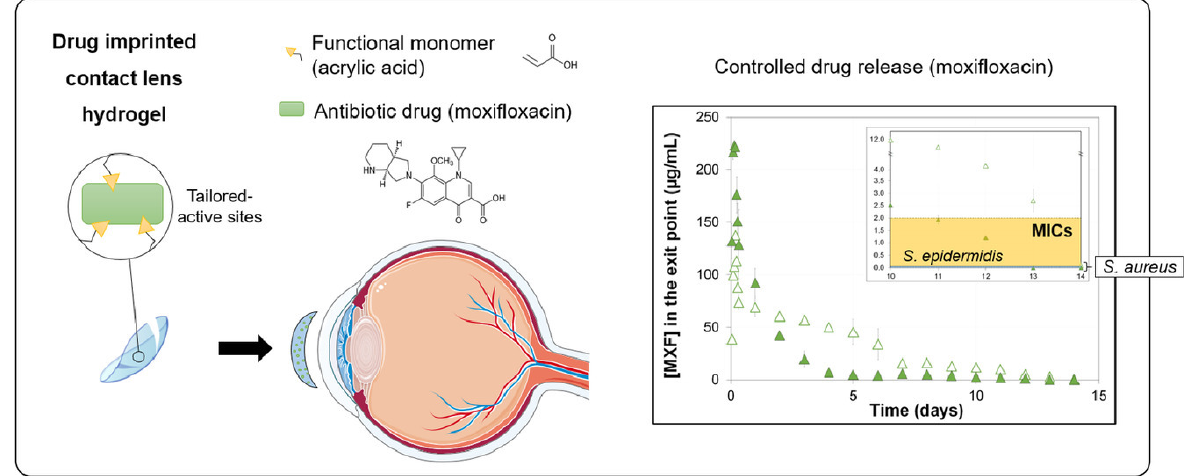
Figure 5 . Drug - loaded contact lens hydrogel [201]. Figure 5. Drug-loaded contact lens hydrogel [201].